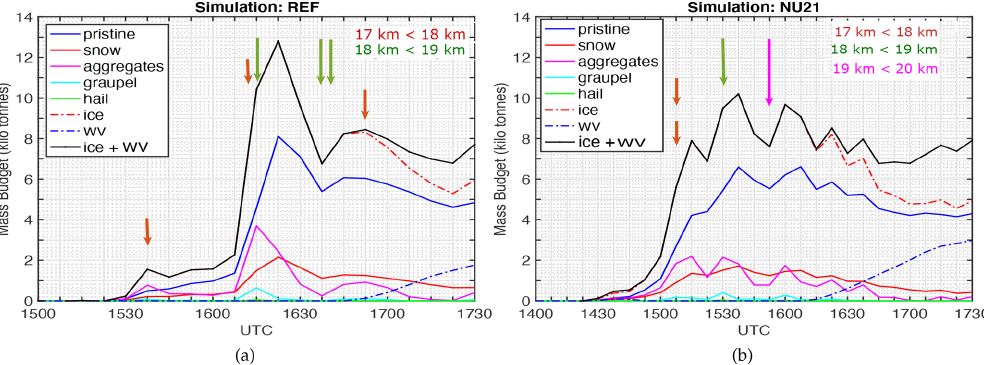
Figure 8. Water mass budget (ice and water vapour) for (a) REF and for (b) NU21 in the third grid between the 380 and 430K isentropic levels. The ice budget contribution includes the five ice hydrometeors (pristine ice, snow, aggregates, graupel, and hail). The colour and length of the arrows indicate the cloud-top altitude of each occurrence, with the smallest arrows (brown) referring to cloud-top heights of 17–18km, the intermediate-sized arrows (green) relating to cloud-top heights of 18–19km, and the largest arrows (magenta) corresponding to cloud-top heights greater than 19km. Table 2. Mass (%) of individual ice hydrometeors within the 380 to 385K isentropic layer ( ρ 1 ) and 380 to 430K isentropic layer ( ρ 2 ), respectively, with respect to its total ice mass within the 380 to 430K isentropic layer. Results are tabulated for four different cases: the first two rows for REF and the rest for NU21. Cases Pristine Snow